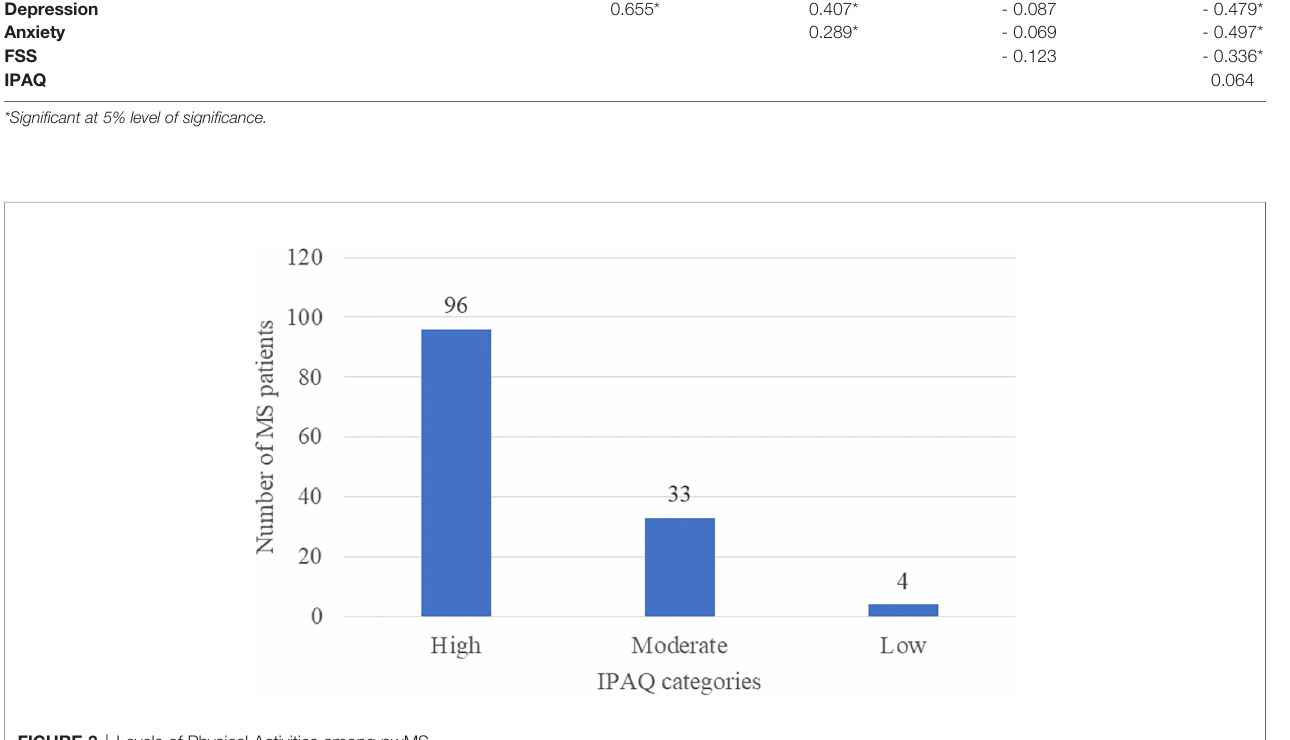
FIGURE 3 | Levels of Physical Activities among